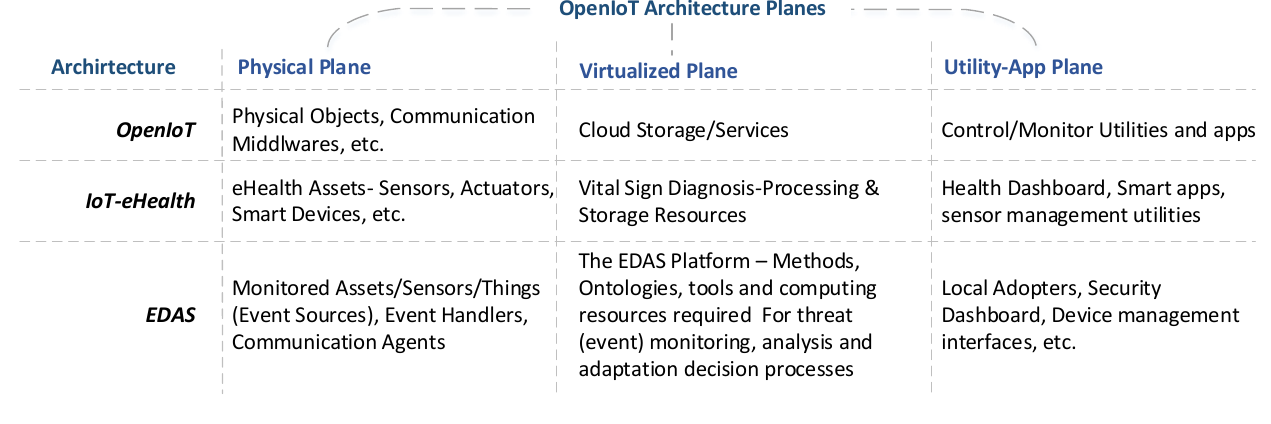
Figure 18. EDAS utilization in OpenIoT